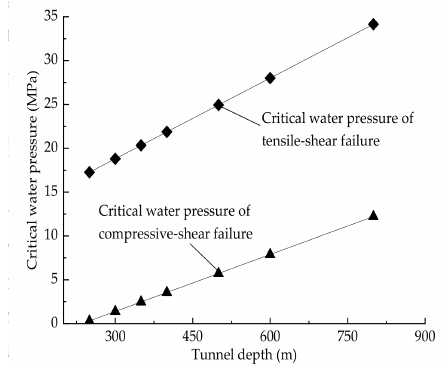
Figure 2. Comparison between the critical water pressures of two splitter failure